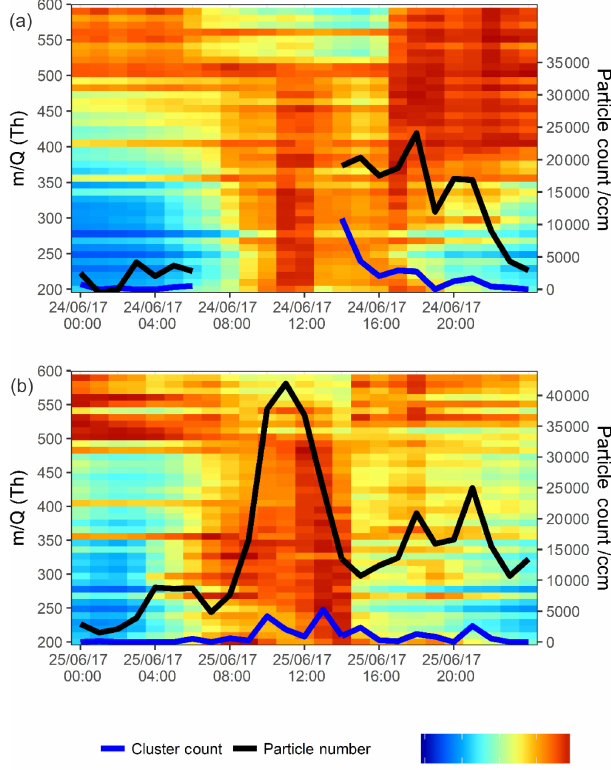
Figure 5. Normalized unit mass NO − CI-APi-ToF-MS signal inten- 3 sity on 24 June 2017 (a) and 25 June 2017 (b) . Each individual unit mass was normalized to a maximum of 1. Each period is normalized separately so the individual signal maxima on each day are visible. The graph is plotted between 200 and 600 mass units, with every 10 mass units averaged for simplicity. On the secondary axis PSM data are plotted, both total particle count > 1 . 30nm (black trace) and total clusters between 1.30 and 1.84nm (blue trace). Data are plotted at 1h time